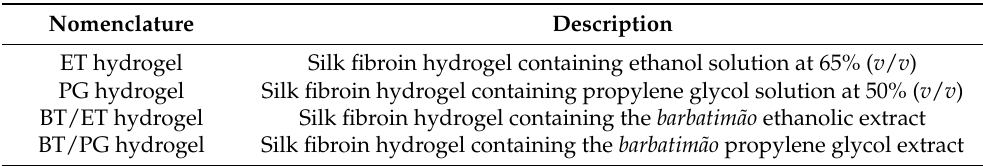
Table 1. Nomenclature for hydrogels used in this